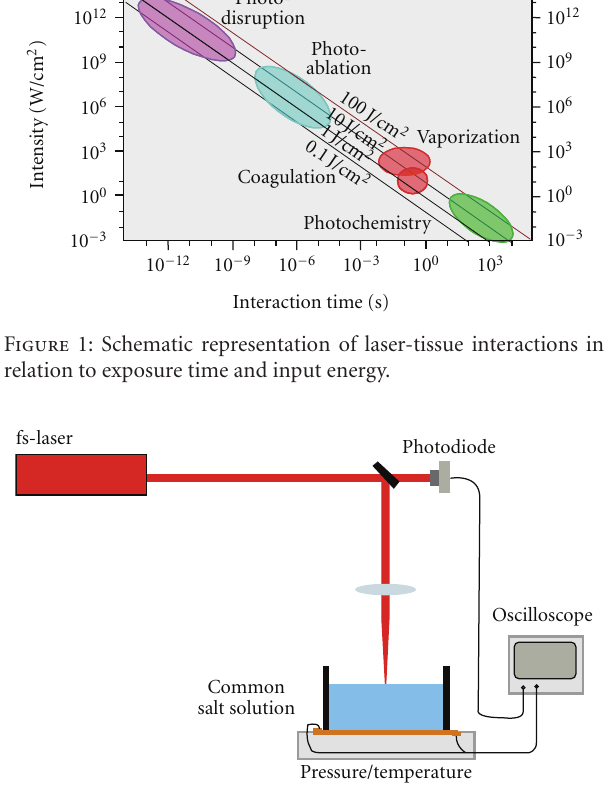
Figure 2: Plexiglas model of the inner ear with a target volume of 0.3ml